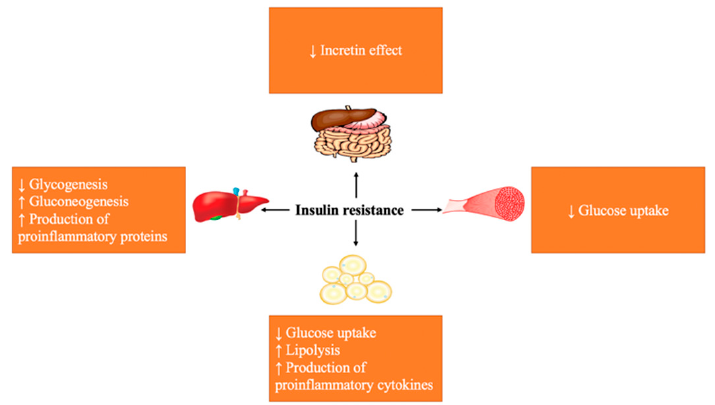
Figure 1. Effects of insulin resistance on body organs and tissues.